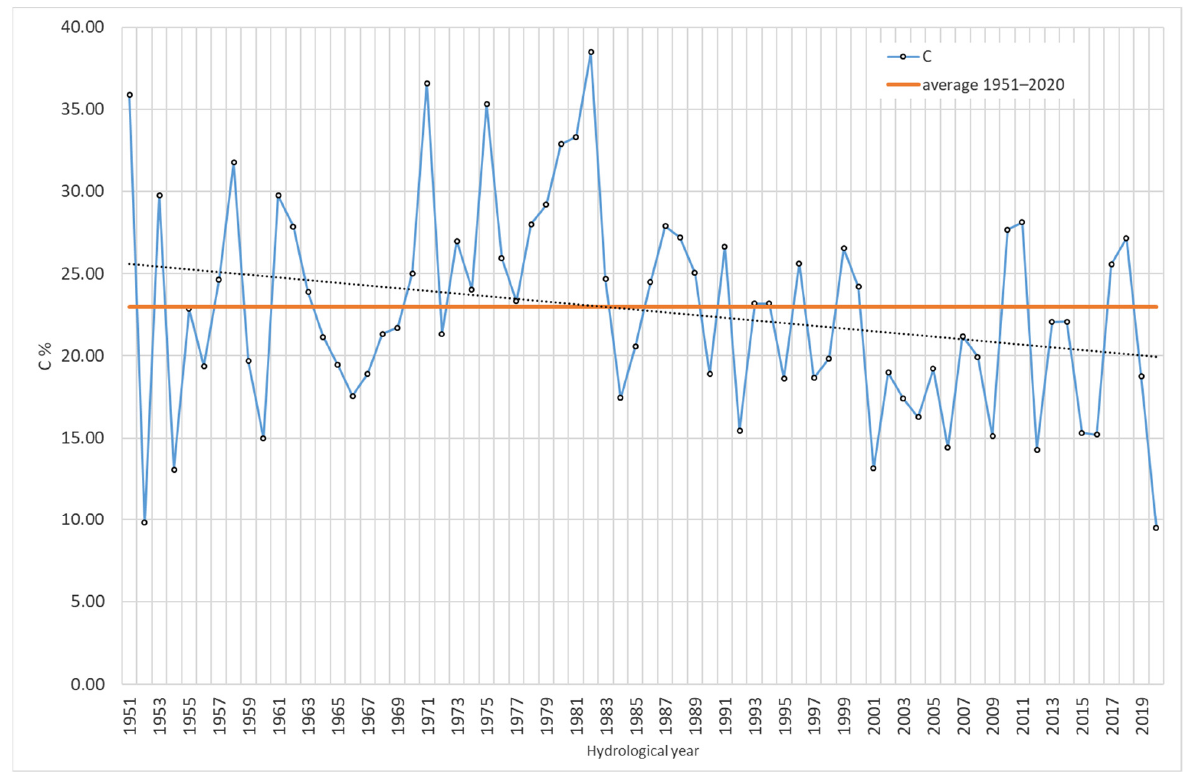
Figure 11. Runoff coefficient (c) in the period of 1951–2020 at the Narewka gauging station.